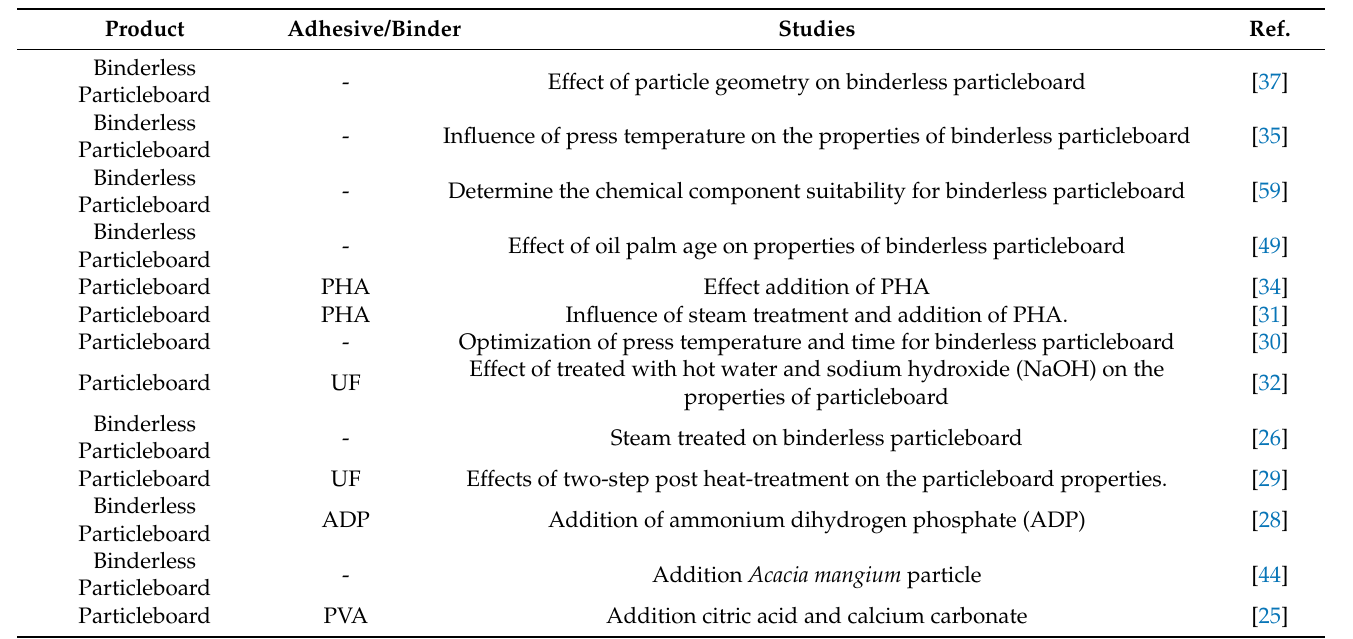
Table 4. Several studies and modifications oil palm trunk (OPT) for particleboard